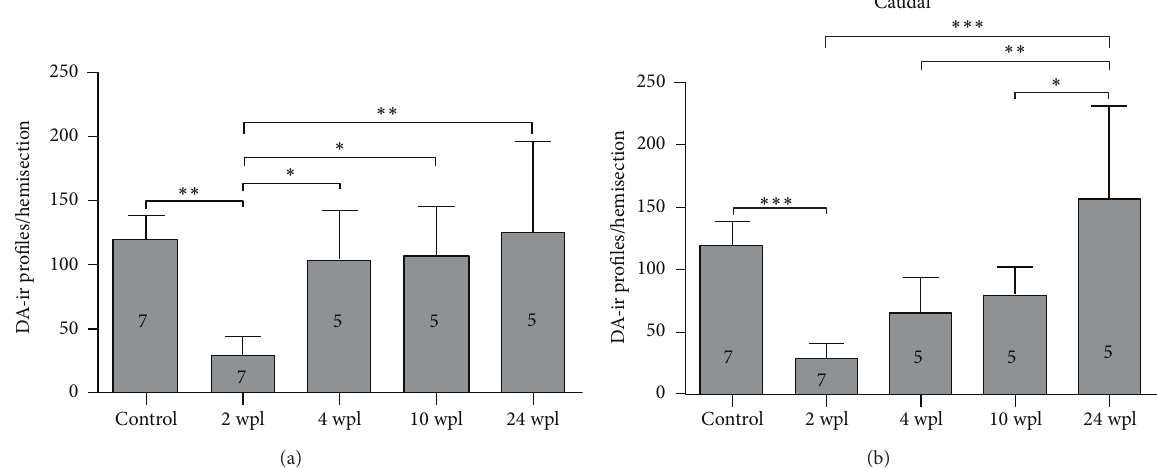
Figure 5: Dopaminergic profile numbers are recovered after a complete spinal cord injury. (a) Quantification of dopaminergic profiles in the rostral spinal cord (ANOVA, 𝑃 = 0.0009 with Bonferroni’s posttest, ∗ 𝑃 < 0.05 , ∗∗ 𝑃 < 0.01 , and ∗∗∗ 𝑃 < 0.0001 ). (b) Quantification of dopaminergic profiles in the caudal spinal cord (ANOVA, 𝑃 < 0.0001 with Bonferroni’s posttest, ∗ 𝑃 < 0.05 , ∗∗ 𝑃 < 0.01 , and ∗∗∗ 𝑃 < 0.0001